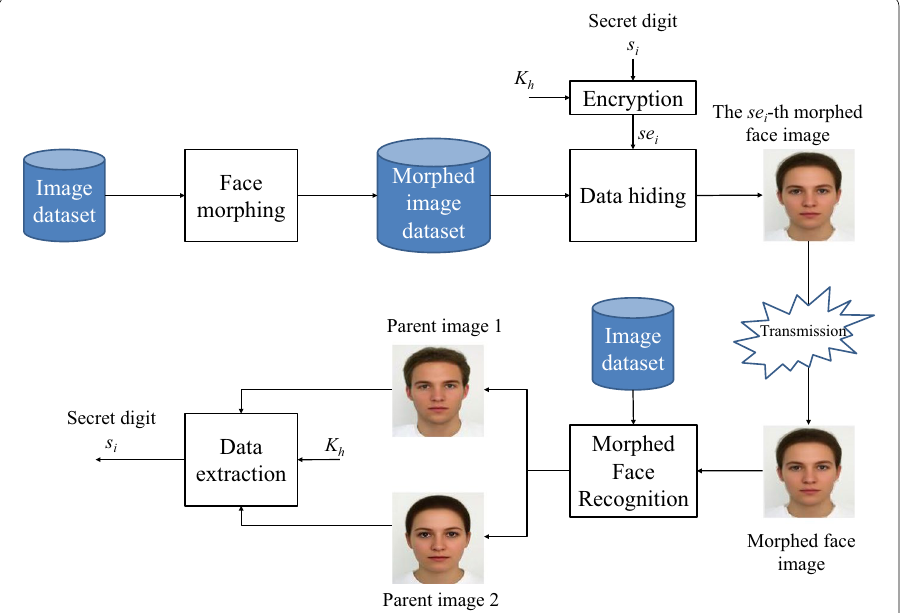
Fig. 2 Flowchart of our approach for secret message